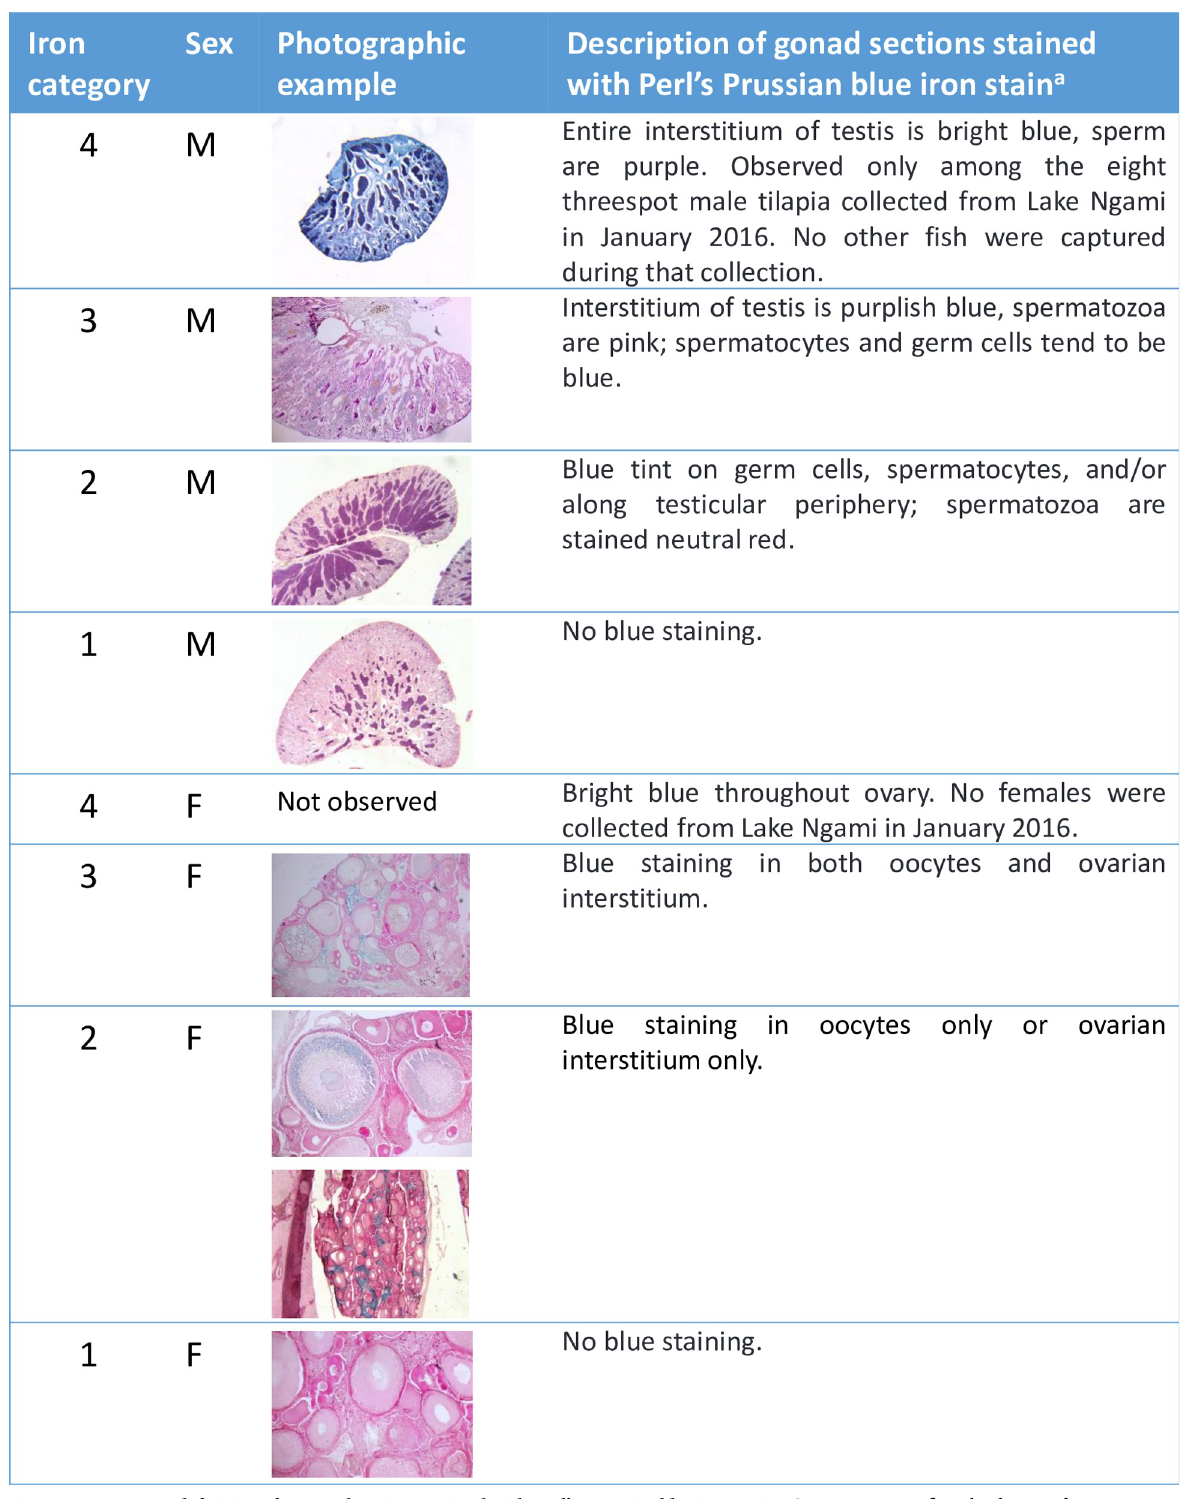
PLOS ONE | https://doi.org/10.1371/journal.pone.0235667 July 30, 2020 8 /